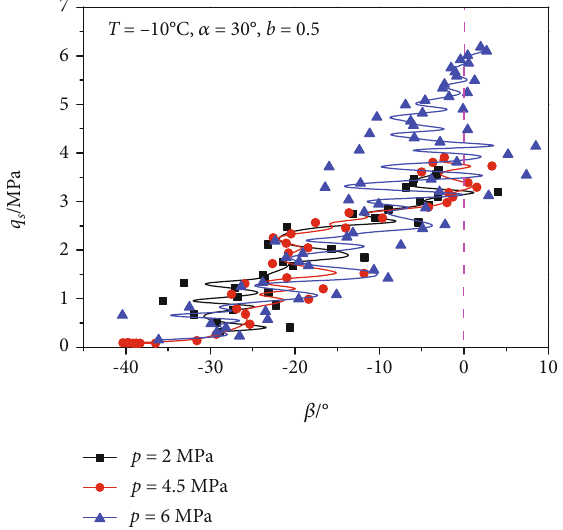
Figure 17: Variations of non-coaxial angle with shear stress under mean principal